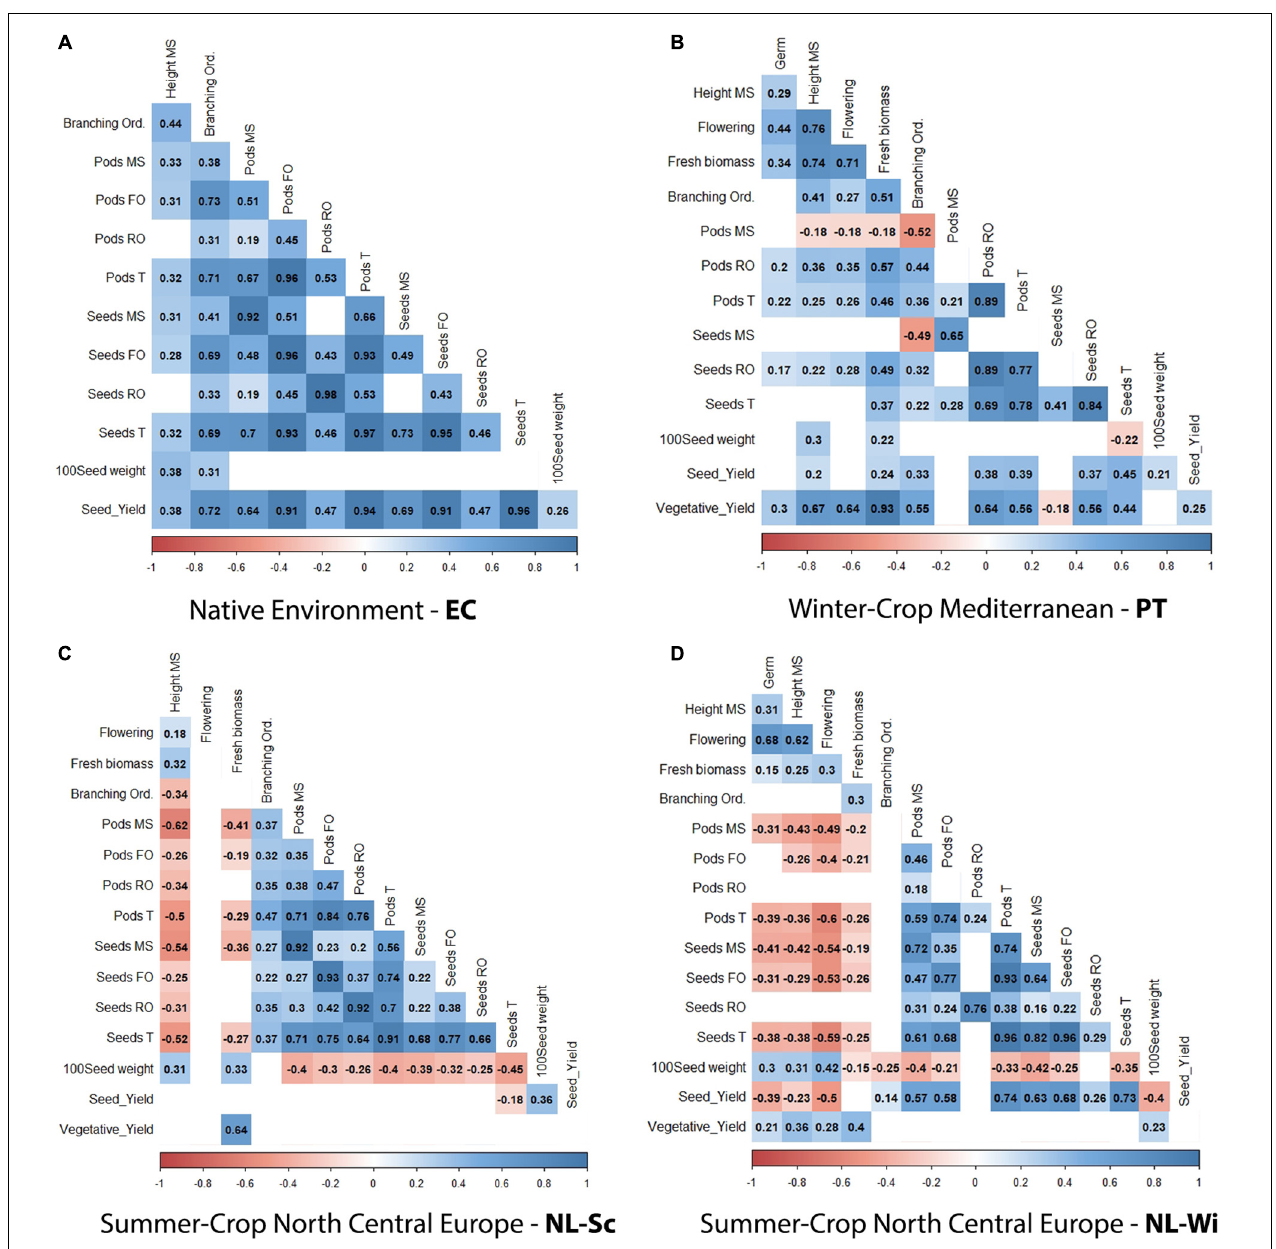
FIGURE 4 | Correlation analysis between scored phenotypic traits (BLUEs data), presented per single field trial: (A) Ecuador, (B) Portugal, (C) NL-Sc, and (D) NL-Wi. Red and blue squares indicate significant positive or negative correlation ( p -value < 0.01), whereas blank cells indicate no significant correlation ( p -value >